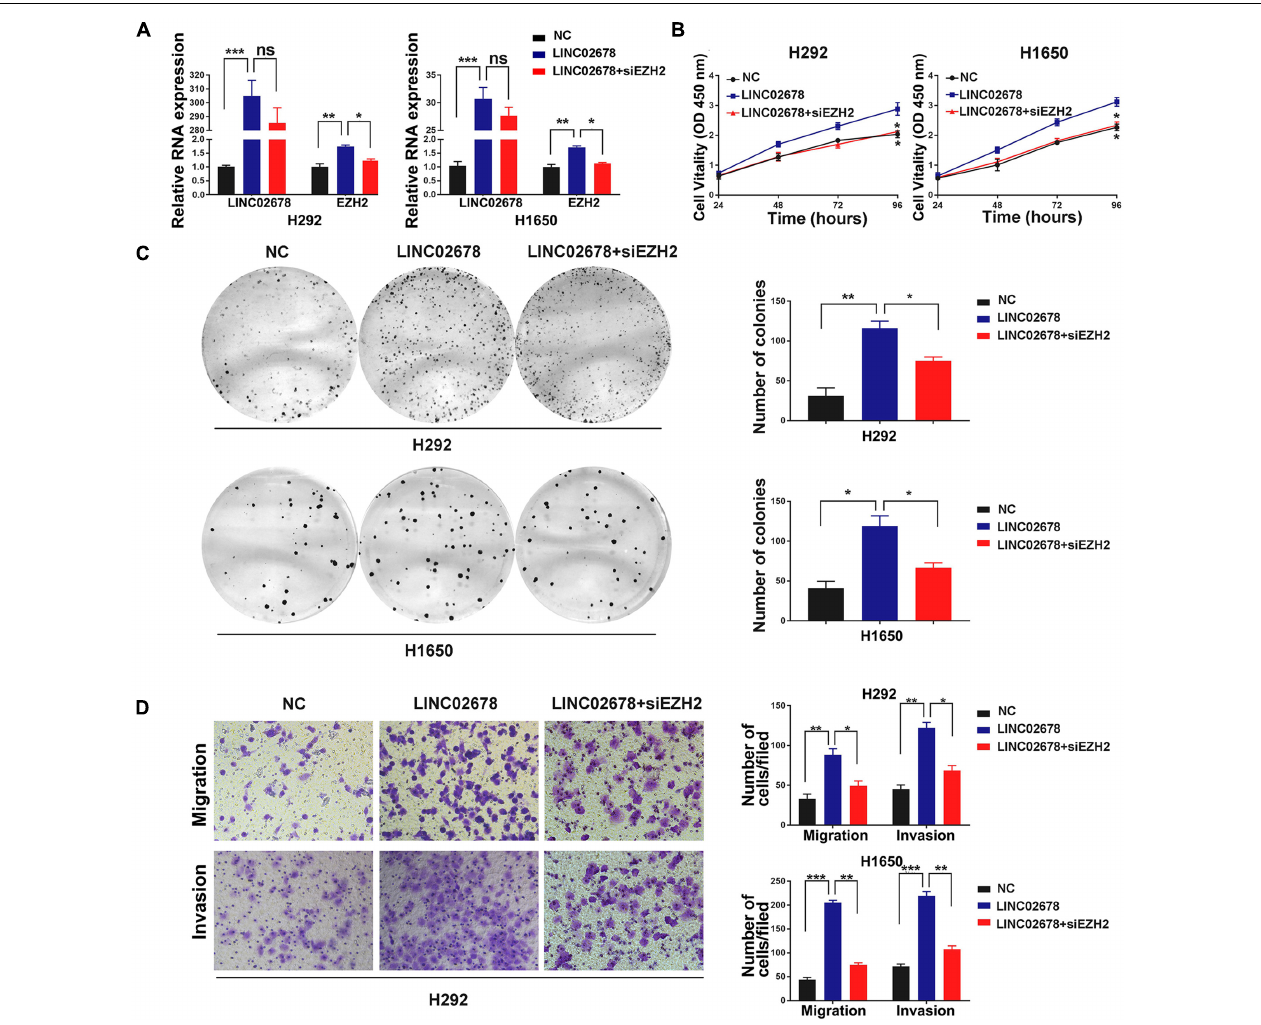
FIGURE 6 | EZH2 is required for LINC02678-induced malignant phenotype. (A) RT-qPCR showed LINC02678 and EZH2 expression in H292 and H1650 cells transfected with NC, LINC02678 or LINC02678 + siEZH2. (B,C) CCK-8 and colony formation analysis showed the proliferation ability of H292 and H1650 cells after transfected with NC, LINC02678 or LINC02678 + siEZH2. (D) Transwell assays were used to estimate metastatic potential in H292 and H1650 cells transfected with NC, LINC02678 or LINC02678 + siEZH2. (* p < 0.05; ** p < 0.01; *** p < 0.001. Data were obtained from three independent